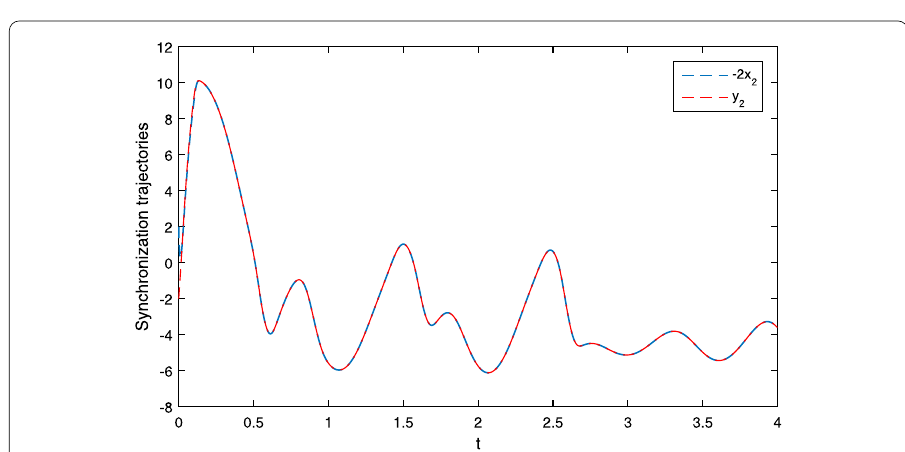
Figure 14 The synchronization trajectories of x 2 , y 2 with β = –2